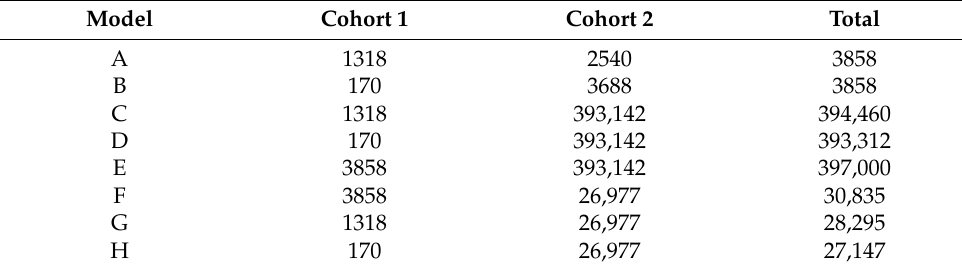
Table 2. Number of available subjects for analysis for the 8